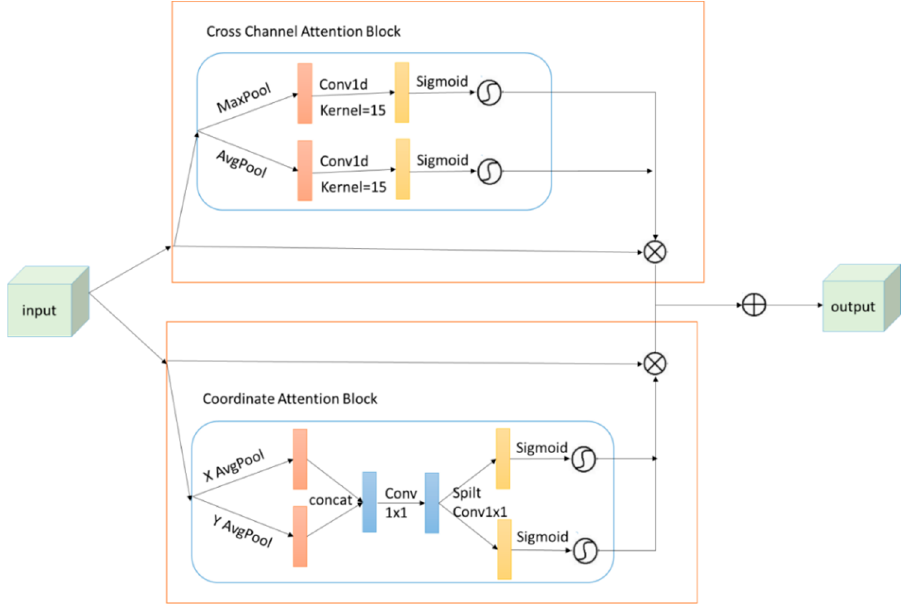
Figure 3. Background filtering module. The background filtering module is composed of a cross-channel attention block (CCAB) and a coordinate attention block (CAB). The weights obtained by the two attention blocks are multiplied by the original feature graph. After adding the two feature graphs, a denoised network can be obtained. The complete calculation details of the background filtering module are as follows: